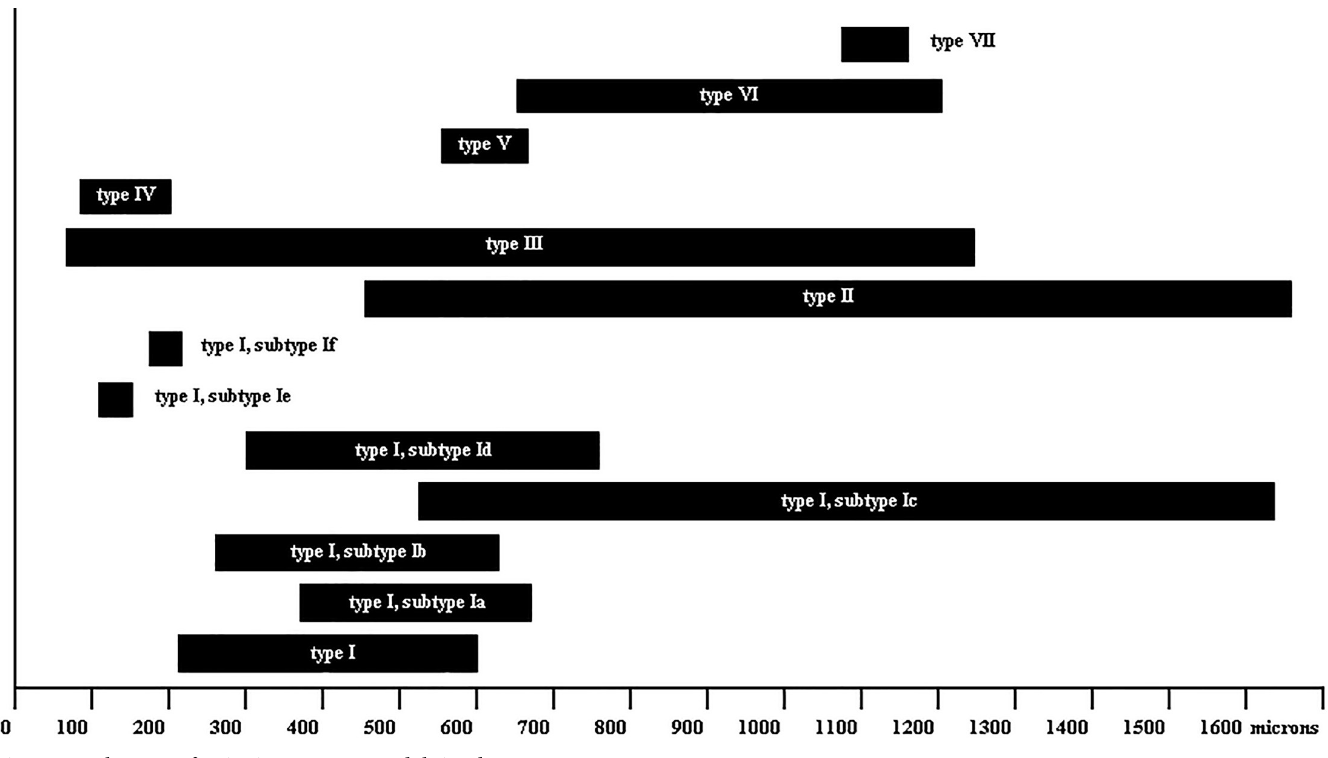
Fig 15. Length ranges of urticating setae types and their subtypes.